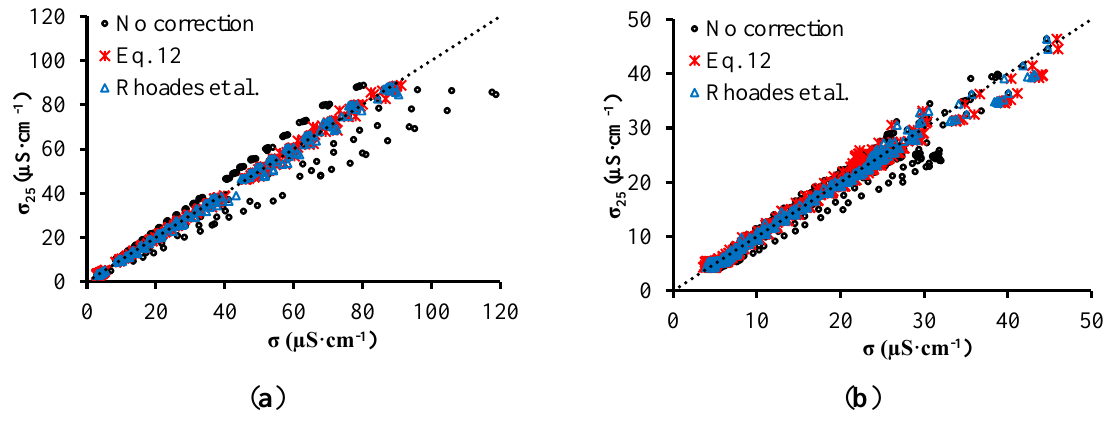
Figure 9. σ-σ 25 relationship for sandy soil ( a ) and clay soil ( b ). Table 1. Results from the comparison between σ correction models based on temperature. Sandy Soil Clay